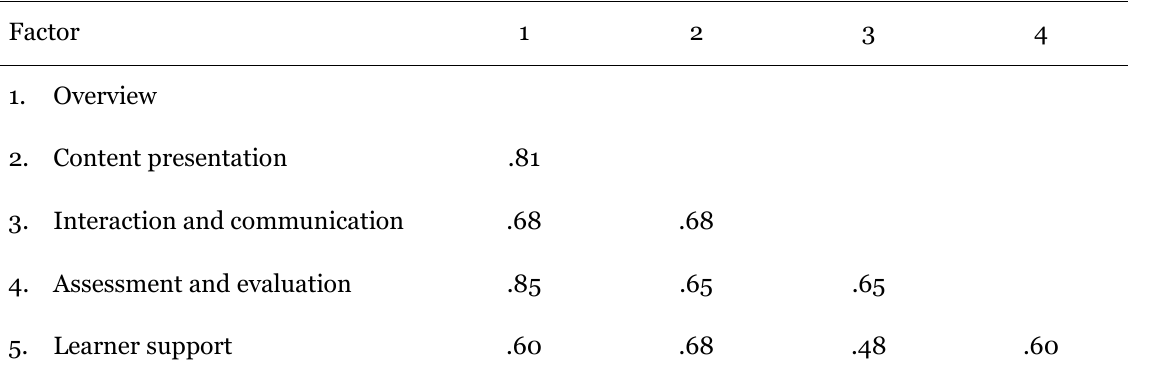
Correlation Coefficients Among the Five Factors of the OCDE